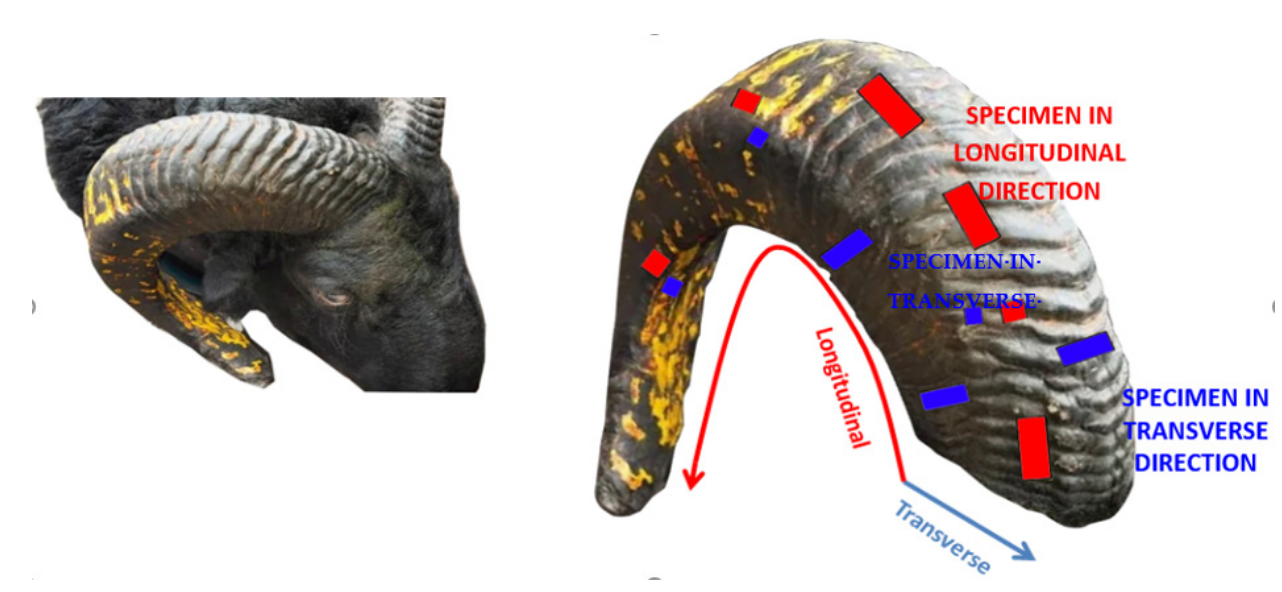
Figure 1. Deccani breed and slicing method for sheep horn.